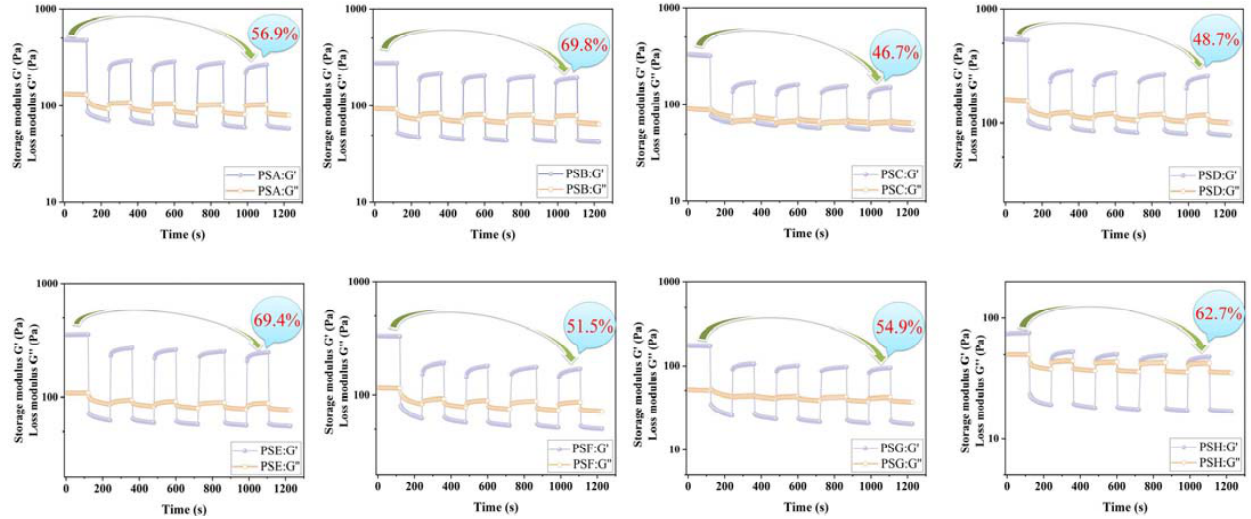
Figure 3. Pectin-salecan hydrogels’ cyclic strain time sweep.